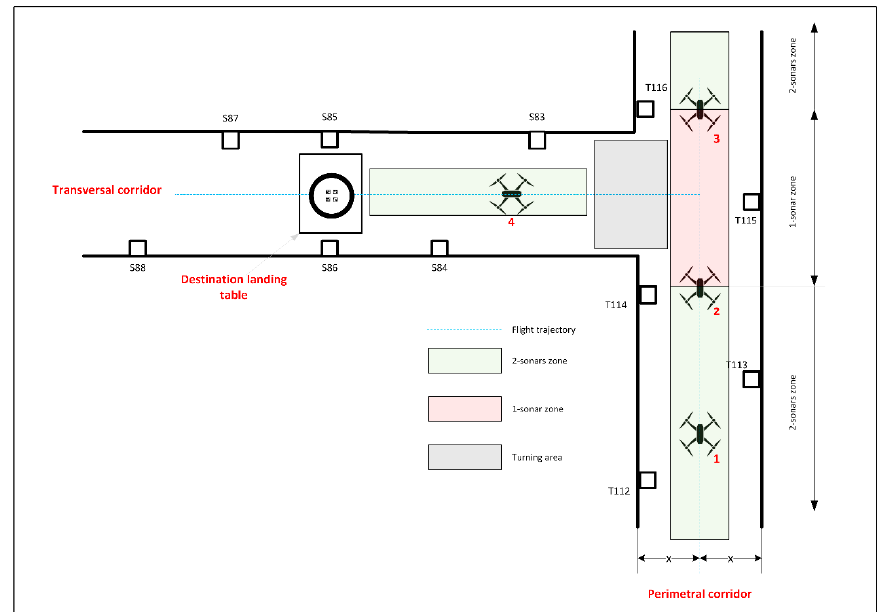
Figure 7. Performing transition from perimetral to transversal corridors.